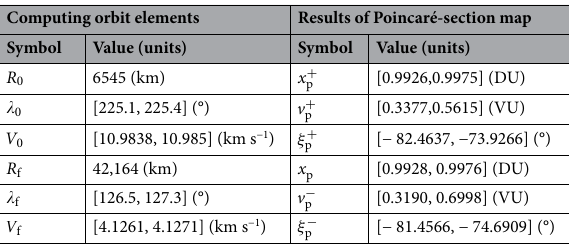
Fig. 7a–d. The blue square is the trans-lunar phase of